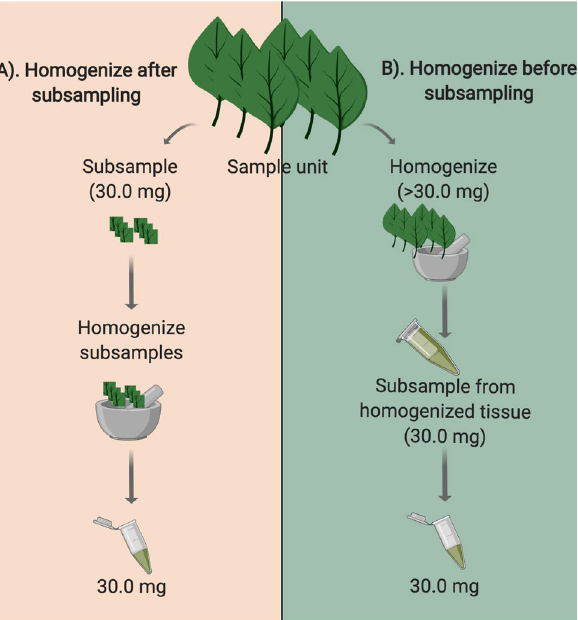
Figure 1. Description of the two common strategies used to subsample plant-associated microbial communities. This figure was created with